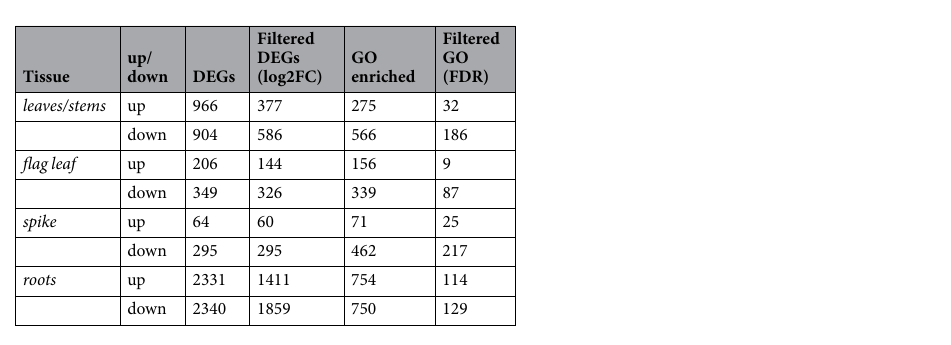
Table 2. Differentially expressed genes (DEGs) and related enriched categories from GO analysis in response to nitrogen stress. Number of total DEGs and number of DEGs filtered by log base 2 of the fold change (log2FC ≥ |1.5|) are shown. For each set of up- or downregulated genes, total GO categories identified from the enrichment analysis, and GO filtered by false discovery rate (FDR ≤ 0.05) are